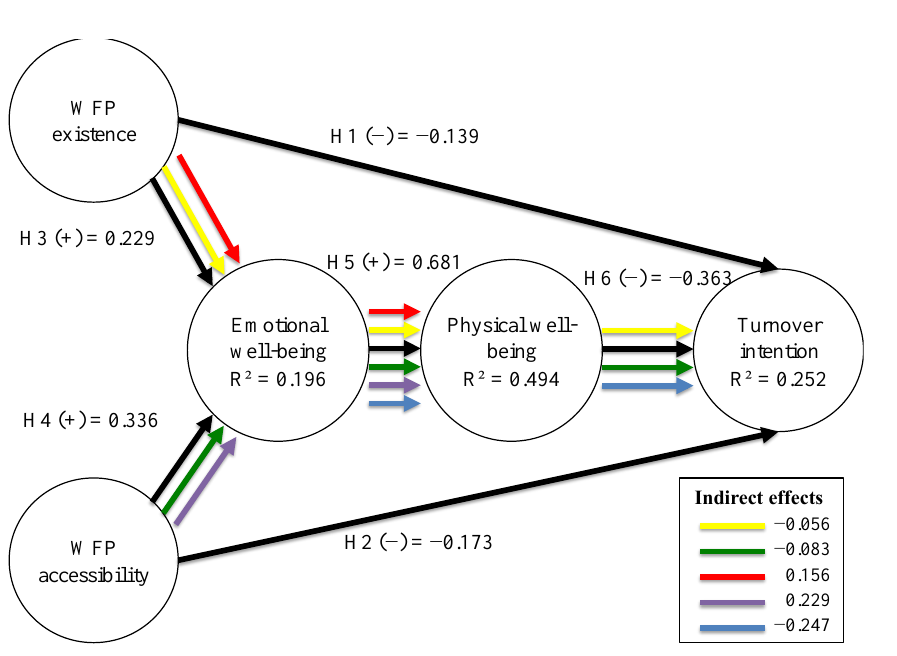
Figure 3. Indirect effects. Diagram.